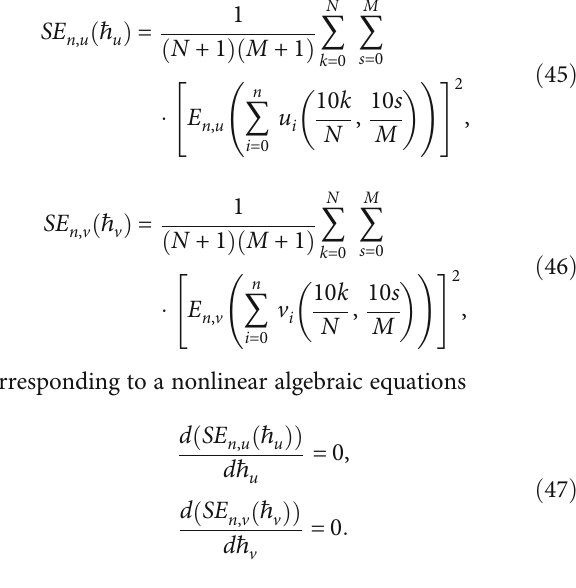
Table 4. Using the command “ Minimize ” in Mathematica,